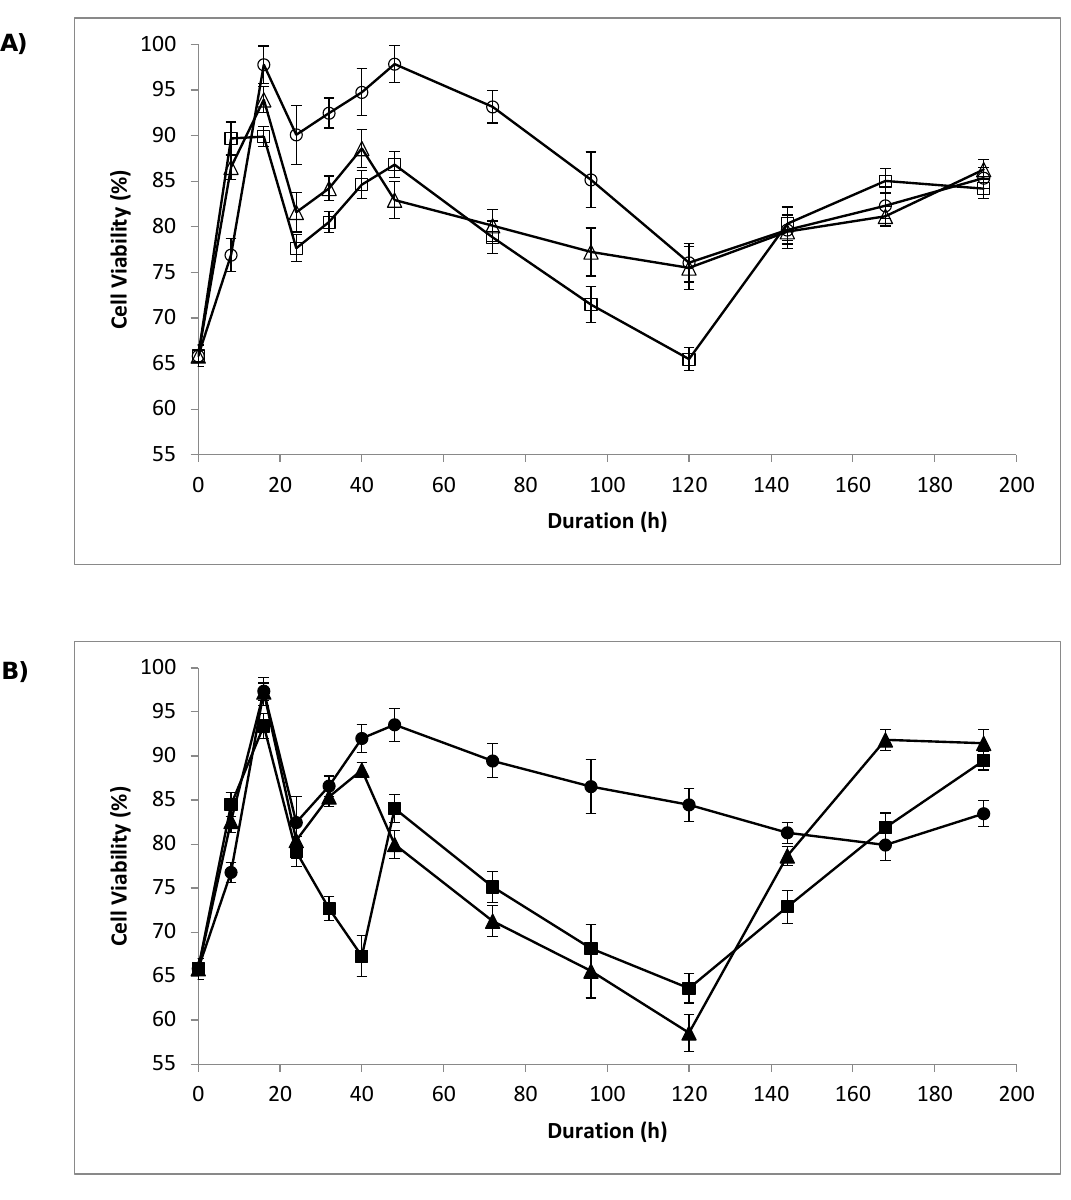
Figure 1. ( A ) Yeast cell viability (%) of non-NaCl-stressed cells during various fermentation times (h) with three different media containing 200, 300, or 400 g/L glucose ( n = 3 replications for each time). ( B ) Yeast cell viability (%) of NaCl-stressed cells during the fermentation process (h) with three different media containing 200, 300, or 400 g/L glucose ( n = 3 replications for each time) ( 0% NaCl), ( ∆ ): (300 g/L glucose, 0% NaCl), ( (cid:3) ): (400 g/L glucose, 0% NaCl), ( ): (200 g/L glucose, 6% NaCl), ( (cid:78) ): (300 g/L glucose, 6% NaCl), ( (cid:4) ): (400 g/L glucose, 6%